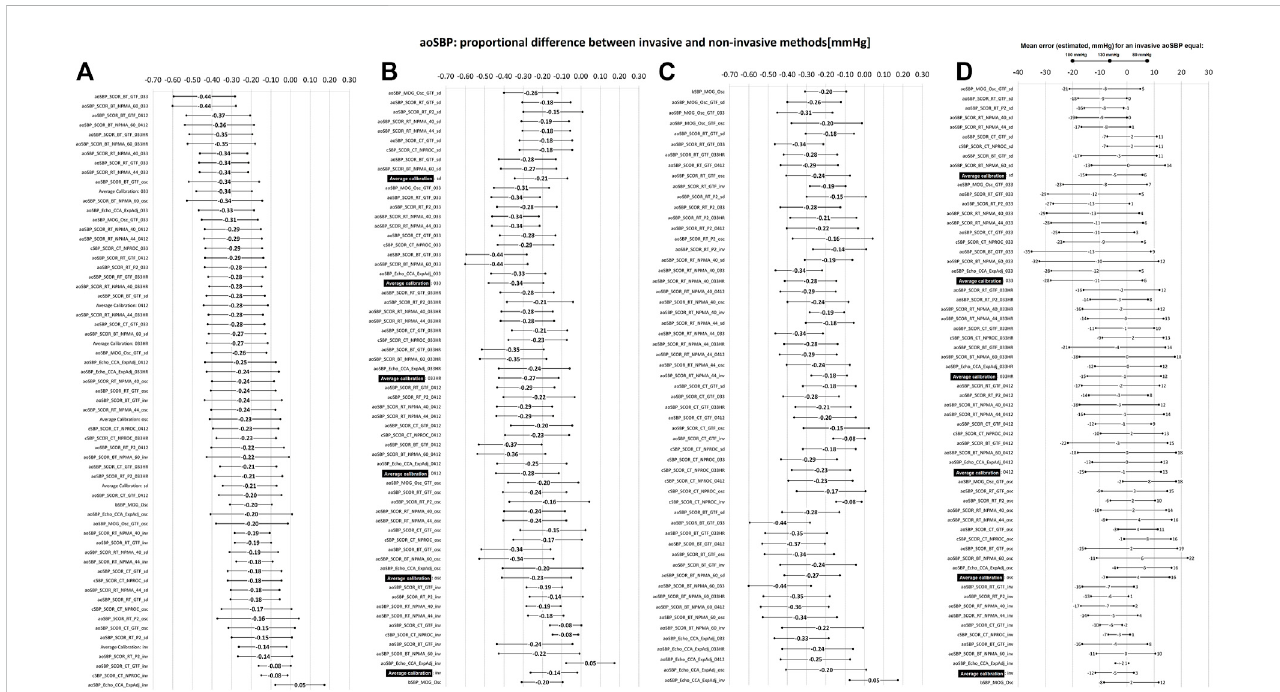
FIGURE 4 Bland-Altman derived proportional error (and 95% con fi dence interval) for comparisons between non-invasive and invasive aoSBP measurements. (A) : orderedaccordingtoerrorlevel. (B) :sortedbycalibrationscheme. (C) :sortedaccordingtomethodusedtoobtainaoSBP. (D) :error(inmmHg)betweennon- invasiveandinvasivemethodplottedforthreedifferentinvasiveaoSBPlevels:80,130and180 mmHg.DetailedquantitativeinformationonBland-Altmantest is provided in Supplementary File S2 (Table